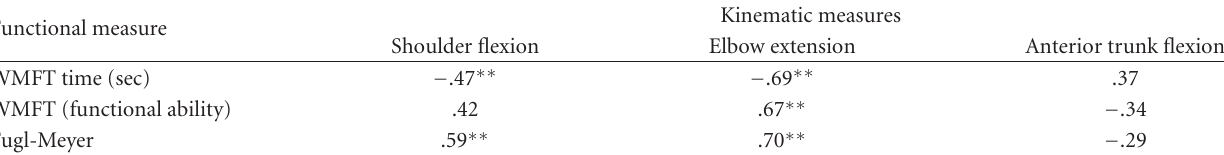
Table 3: Pearson correlation coe ffi cients of functional and kinematic